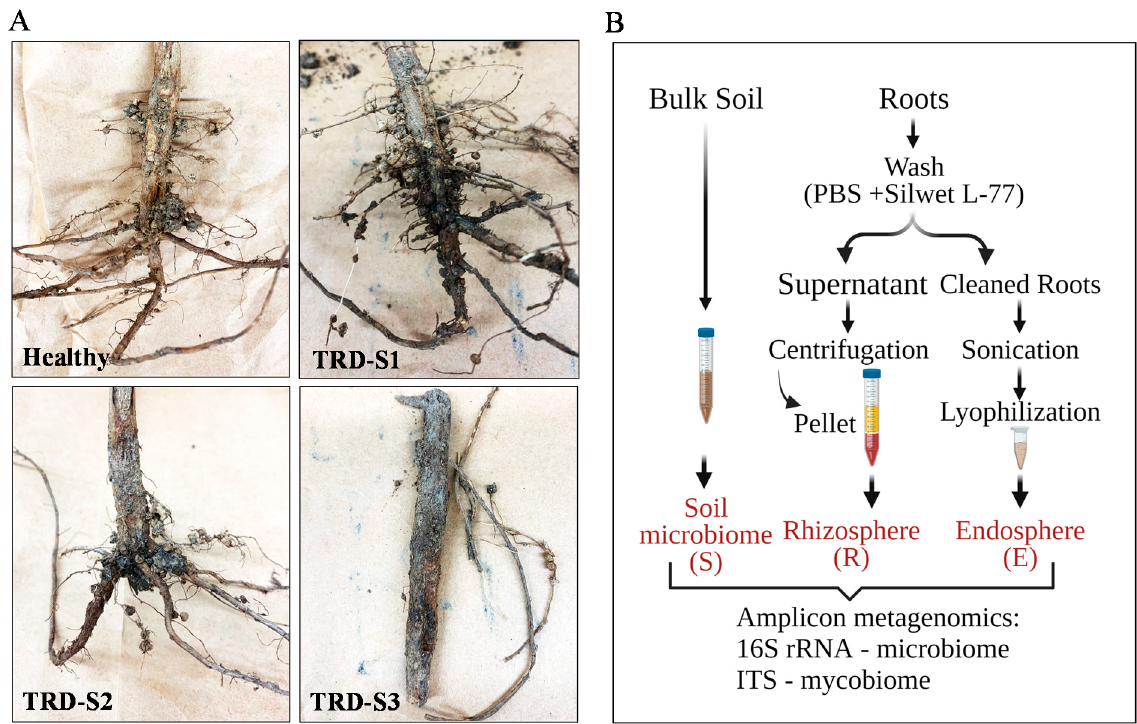
Figure 1. Root material and analysis scheme to investigate the microbiome and mycobiome of healthy and diseased soybean roots. ( A ) Soybean roots were collected from healthy plants and plants showing symptoms of taproot decline (TRD) at incipient (S1), moderate (S2), and advanced (S3) stages of taproot decline disease. Representative images of the roots before processing are shown. ( B ) Root samples and bulk soil collected from the same field site were processed to obtain the microbial and fungal communities of the soil (S), root rhizosphere (R), and endosphere (E). The composition of all samples was investigated using amplicon metagenomics (16S rRNA sequencing and internal transcribed spacer (ITS) regions 1–4 sequencing).